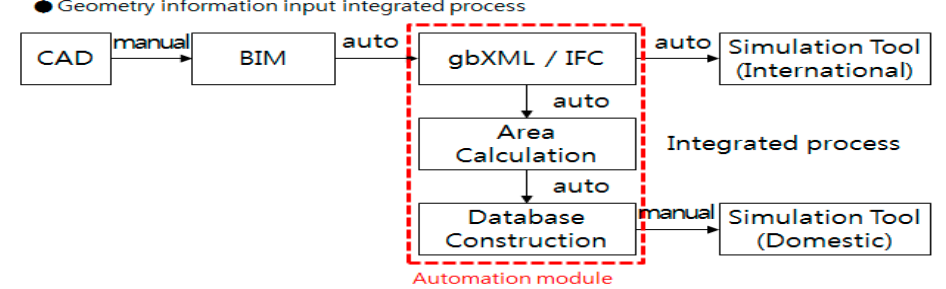
Figure 2. Integrated process for different simulation modes.